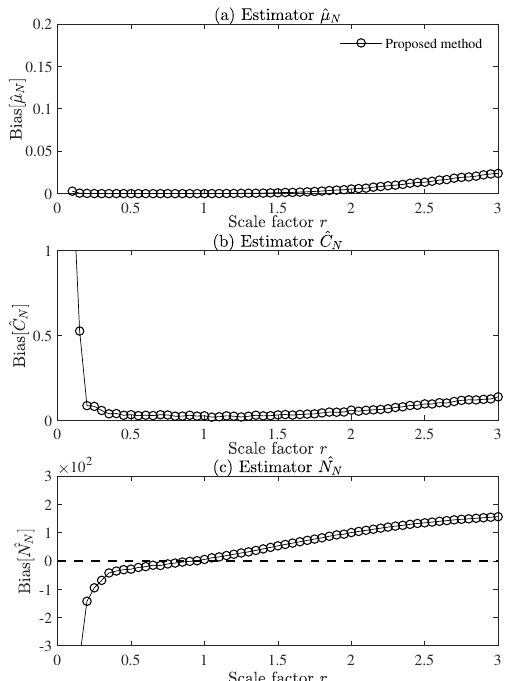
Figure 6. Bias errors for various scale factors r in the proposed